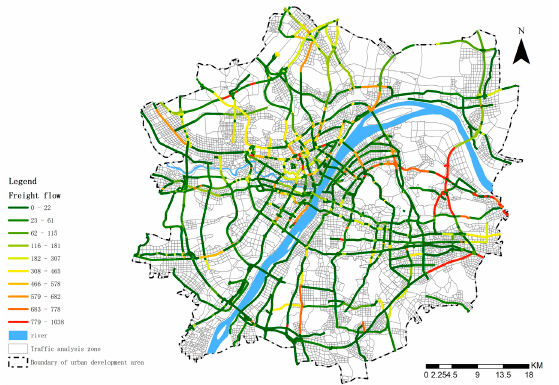
Figure 4. Traffic corridor flow display.